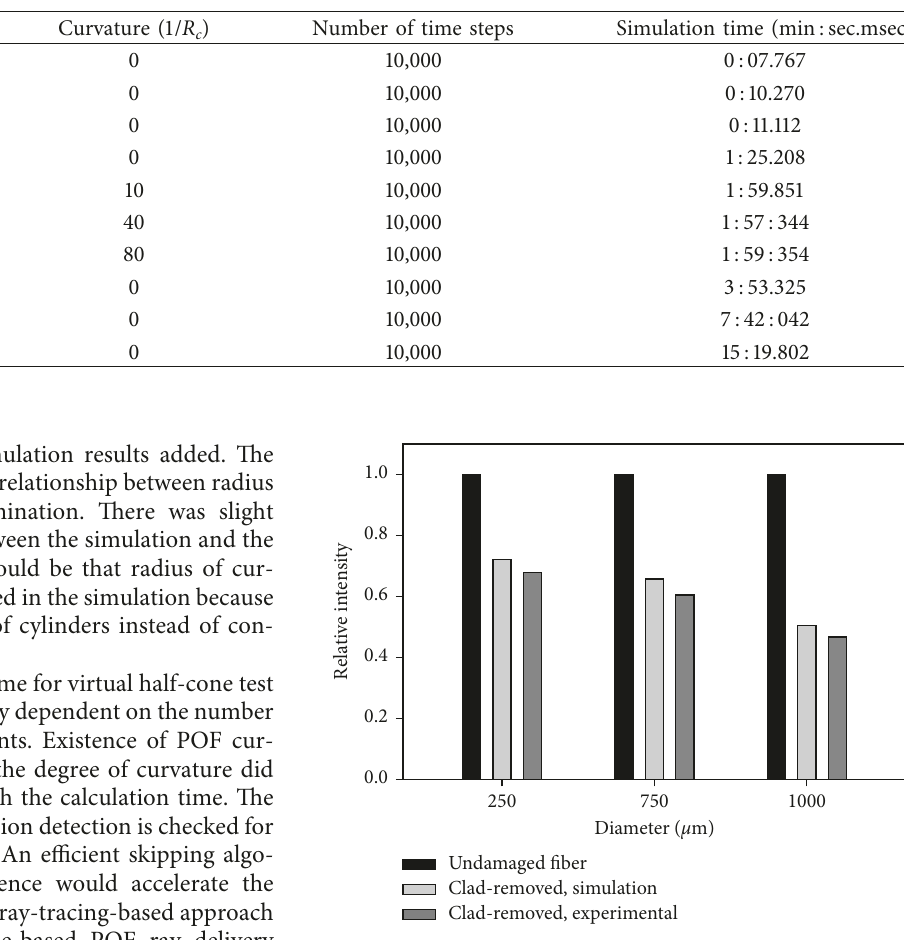
Figure 23: End-tip illumination of POF in plain weave